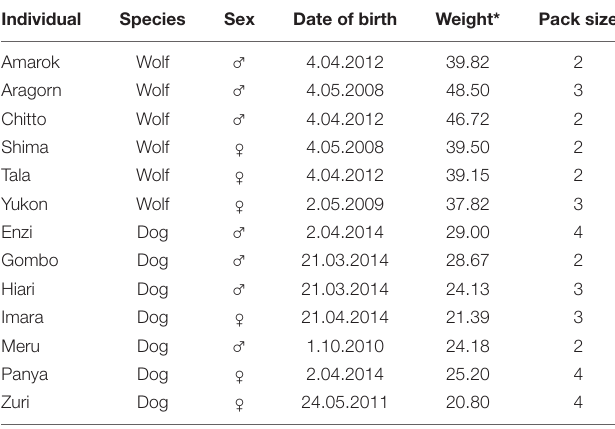
TABLE 1 | List of the